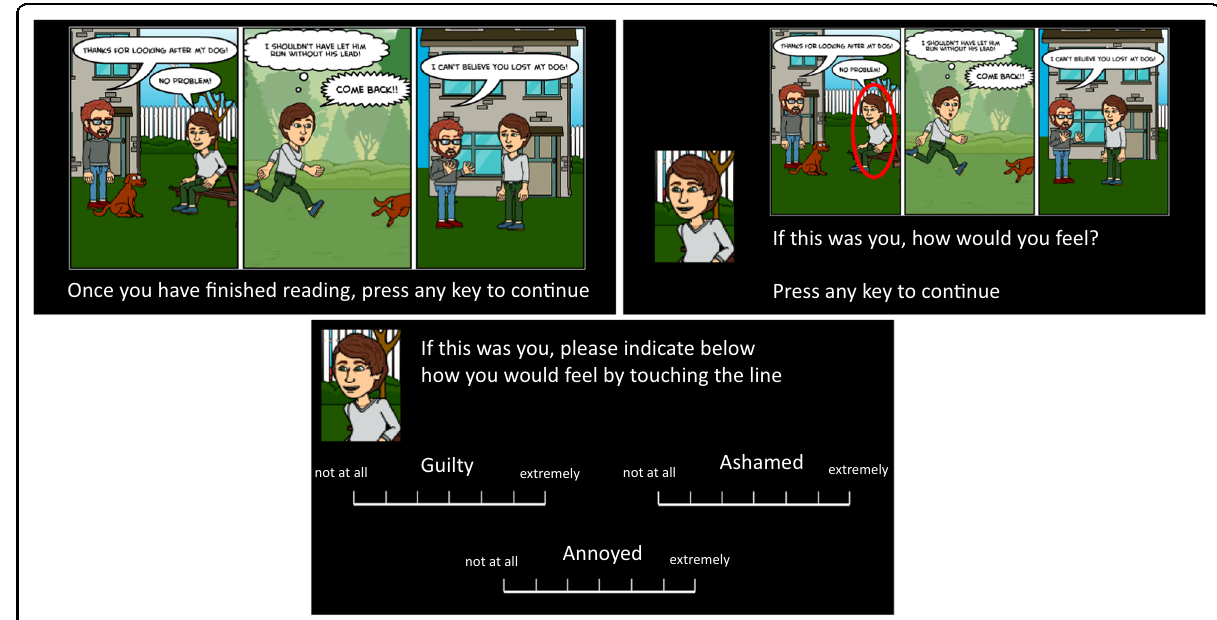
Fig. 1 Moral emotions task schematic 57 . Three example slides of a trial are shown. Feeling “ bad ” was assessed with a rating scale on a fourth